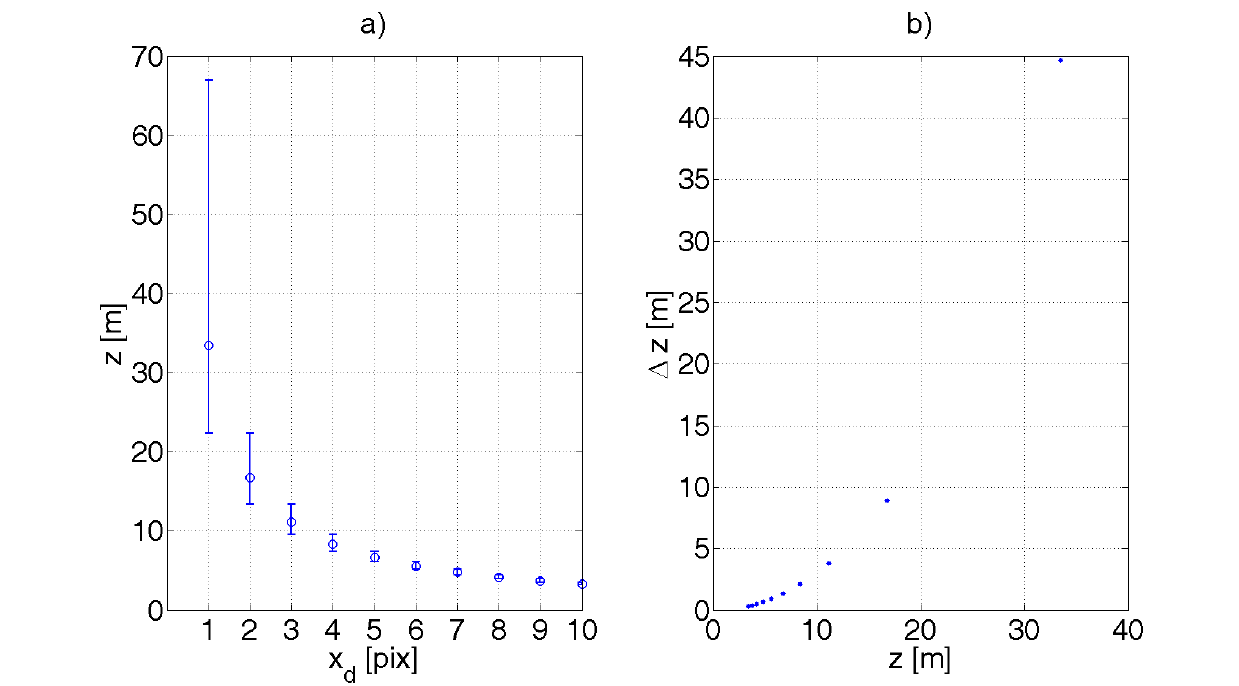
Figure 10. An illustration of the quantization effect on estimating the z coordinate. ( a ) The plot of z and errors thereof as a function of disparity x z calculated from z = Bf/x . Bars symbolizes errors of z when x d error of ± (cid:15) or ± pixel , ( b ) The absolute error of z as a function of the depth z 2 2